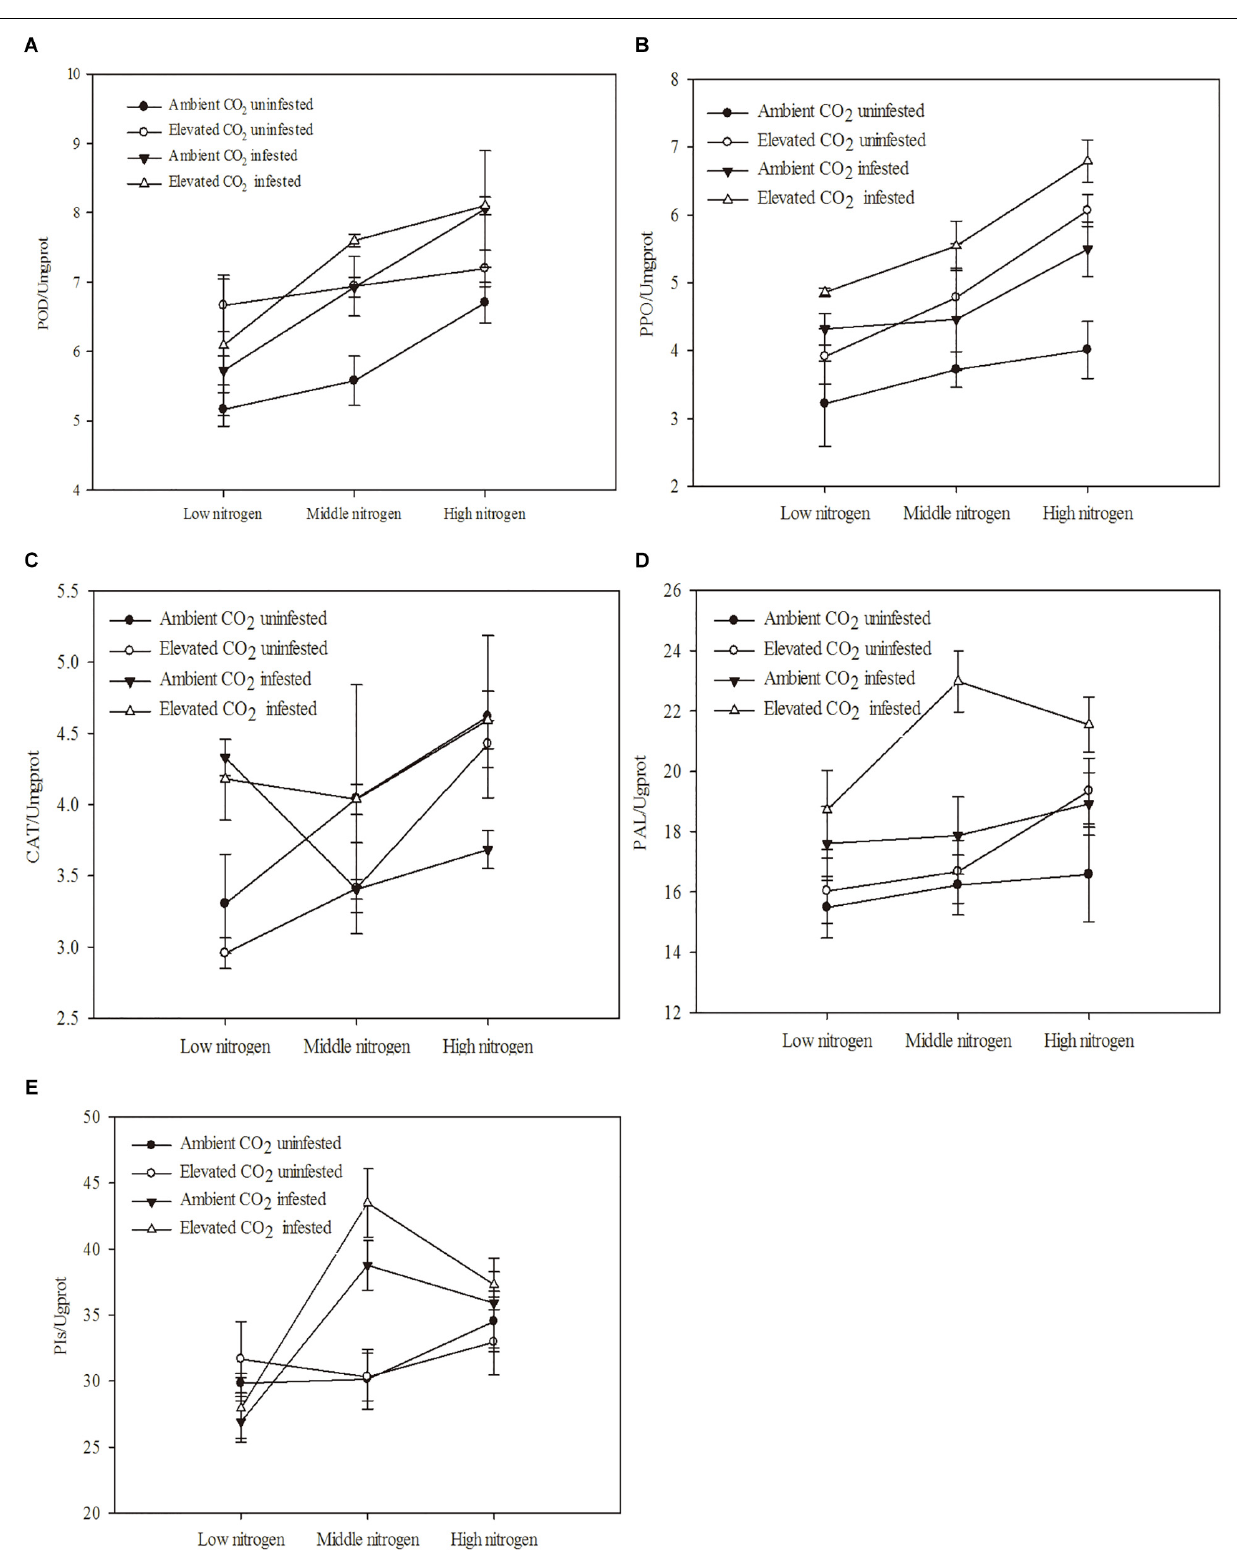
Frontiers in Plant Science |